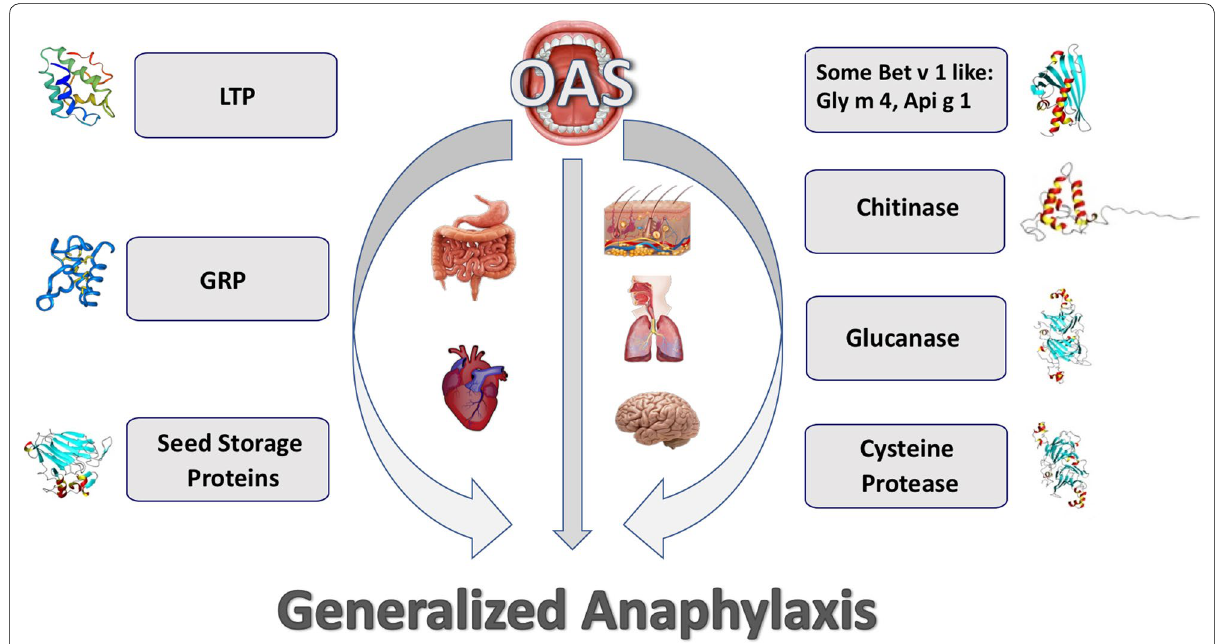
Fig. 4 Schematic representation of the class 1 plant food allergens that may cause OAS and/or trigger allergic reactions in other organs and apparatus. These allergens may even induce severe